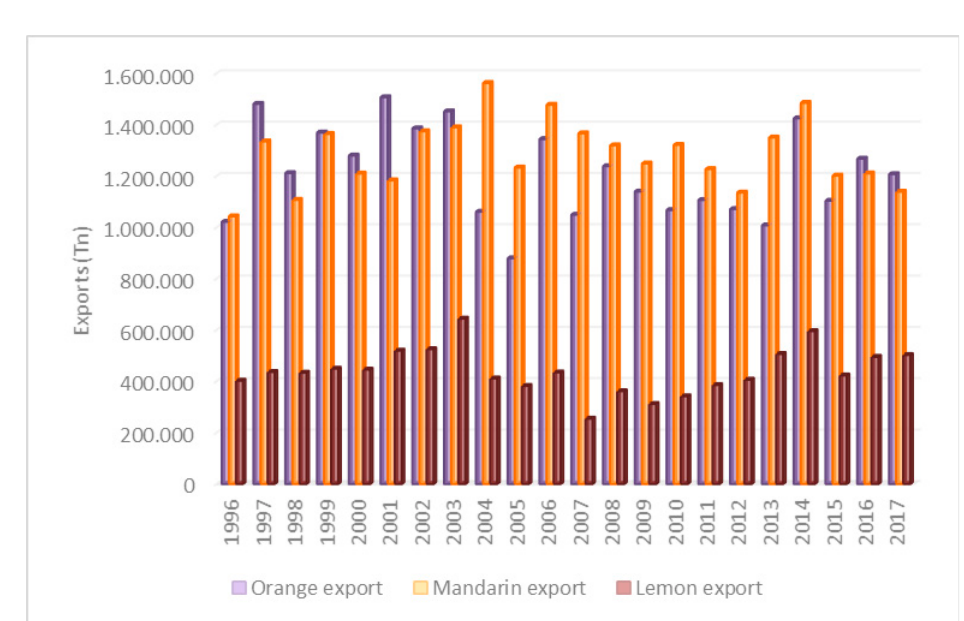
Figure 1. Evolution of yield.